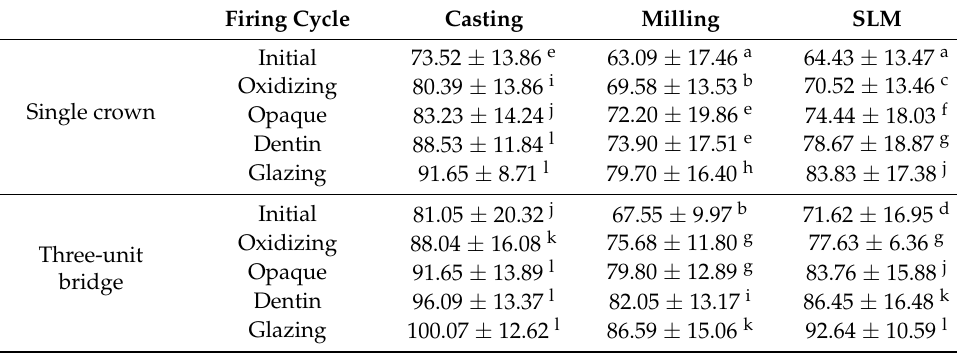
Table 1. Marginal gap of casting, milling, SLM dental